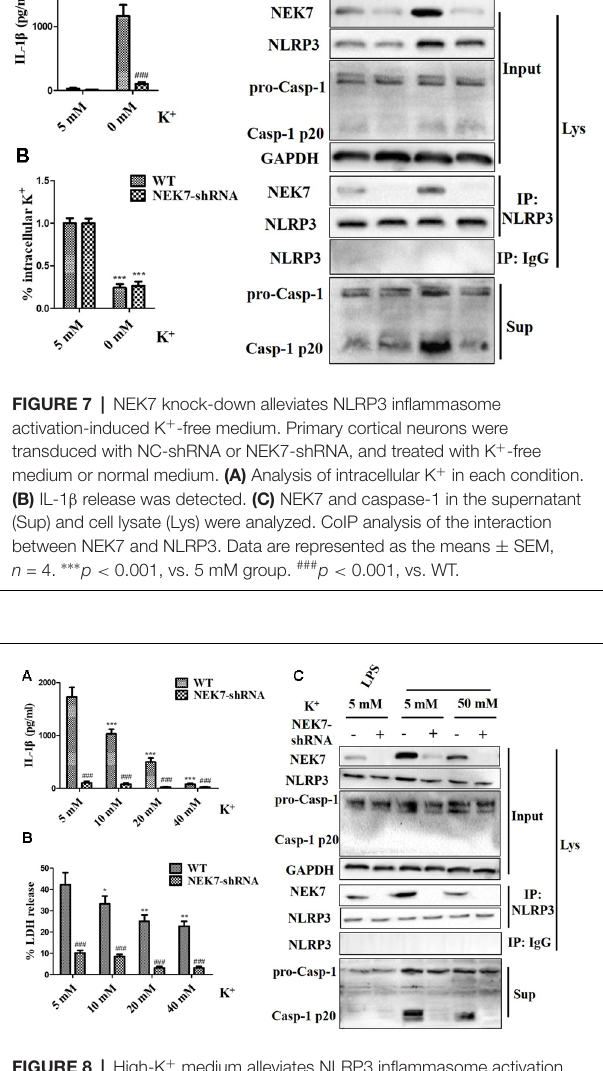
FIGURE 8 | High-K + medium alleviates NLRP3 inflammasome activation induced by LPS + ATP via NEK7. Primary cortical neurons were transduced with NC-shRNA or NEK7-shRNA, stimulated with LPS + ATP, and treated with different concentration high-K + medium, then IL-1 β (A) and lactate dehydrogenase (LDH; B ) release were analyzed. (C) Cells were primed with LPS or LPS + ATP, and then stimulated with 50 mM high-K + medium. NEK7 and caspase-1 in the supernatant (Sup) and cell lysate (Lys) were analyzed in stimulated NC-shRNA or NEK7-shRNA primary cortical neurons. CoIP analysis of the interaction between NEK7 and NLRP3. Data are represented as the means ± SEM, n = 4. ∗ p < 0.05, ∗∗ p < 0.01, ∗∗∗ p < 0.001, vs. 5 mM group. ### p < 0.001, vs.